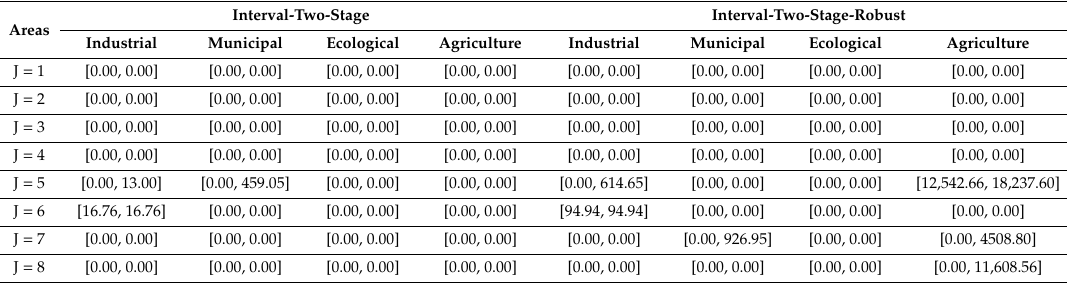
Table 9. Water shortage of ITSP model and ITSR model in di ff erent water use departments under high levels of available water resources in the first planning period (10 4 m 3 /